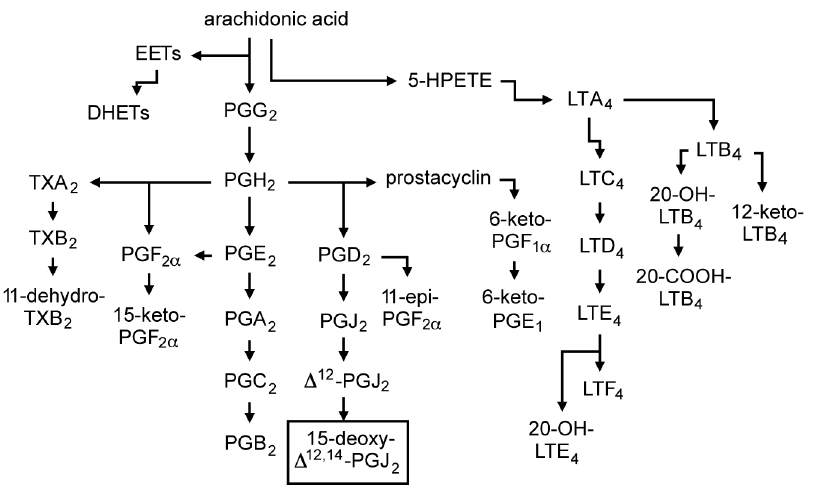
Figure 1. Arachidonic acid metabolism and formation of prostaglandins and leukotrienes. 15d-PGJ 2 is non-enzymatically produced from PGD 2 .